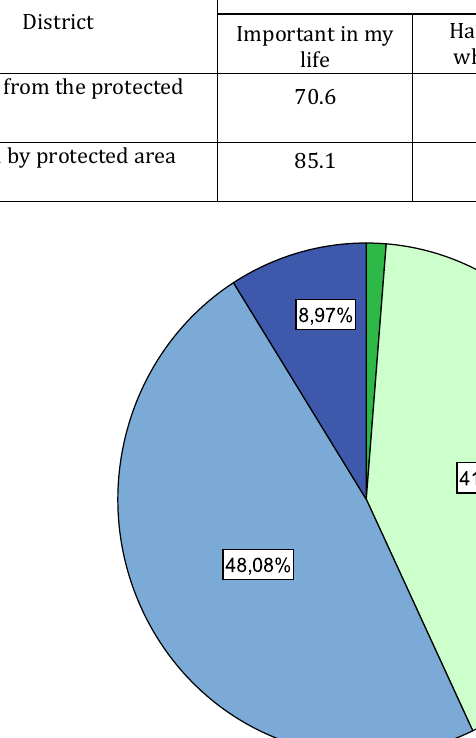
Fig. 2. Evaluation of the knowledge of pupils about the natural environment of